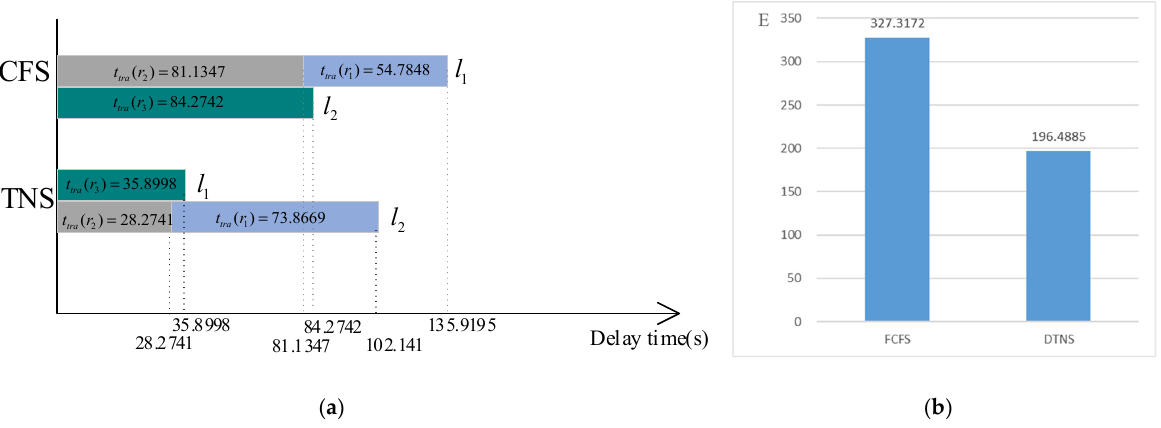
Figure 9. Comparison of efficiency under the condition of two robot-trailer in scenario 1. ( a ) Comparison of towing service time. ( b ) Comparison of delay expectations.